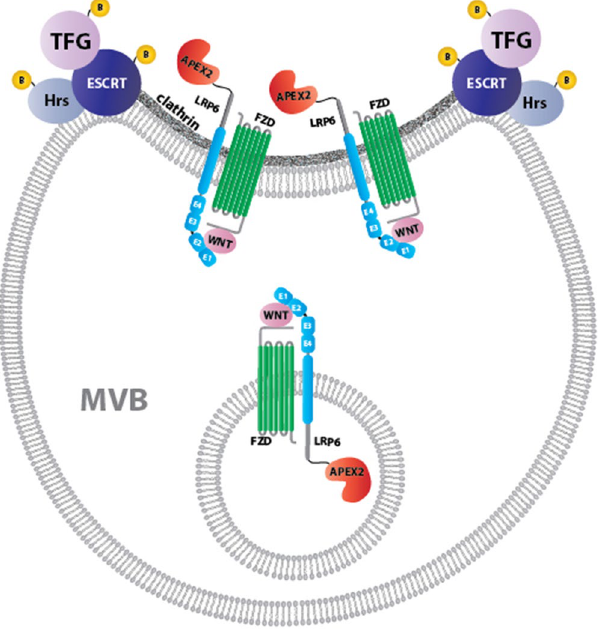
Figure 6. Model of how Lrp6-APEX2 may interact with the ESCRT machinery and TFG in multivesicular body formation during Wnt-induced endocytosis. The endocytosed Wnt receptor complex on the surface of multivesicular endosomes becomes clustered in clathrin-containing invaginations that give rise to the intraluminal vesicles (ILVs) of late endosomes. MVBs are the obligatory pathway through which plasma membrane proteins reach the lysosome. We found that most ESCRT GO components are brought into proximity of Lrp6-APEX2 5 min after treatment with Wnt3a conditioned medium. The top interactor with Lrp6-APEX2 after 20 min of Wnt3a was TFG, which we show here is required for Wnt signaling. TFG protein co-localizes with the ESCRT-0 protein Hrs/Hgs after Wnt stimulation. We did not detect interactions with intraluminal vesicle components such as CD63; a possible explanation is that the acidic medium or lysosomal proteases might interfere with APEX2